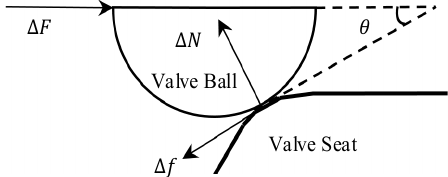
Figure 4. The micro-division of the structure.